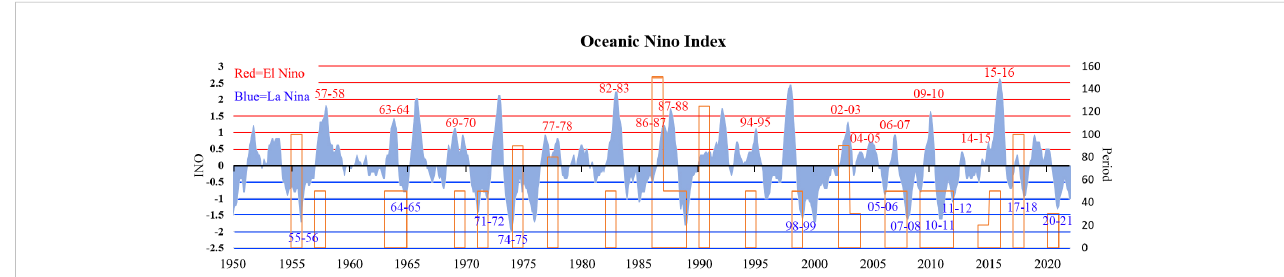
FIGURE 8 ONI of each year since 1950. The ENSO events captured by HHT were marked over the years. Red numbers represent El Niño years recorded by the Hilbert spectrum, and blue numbers represent La Niña years recorded by the Hilbert spectrum. The intensity of ENSO events could be checked in the left part. The orange bars represent the ENSO years recorded by the Hilbert spectrum, the period of which can be seen on the right